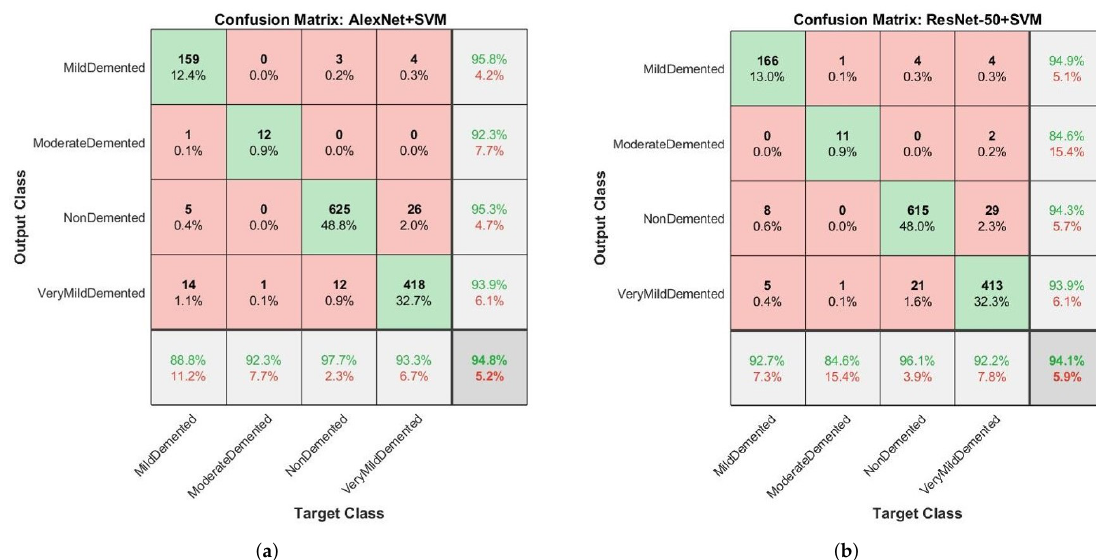
Figure 7. Confusion matrices. ( a ) Confusion matrix for the AlexNet-50+SVM to evaluate Alzheimer’s disease. ( b ) Confusion matrix for the ResNet+SVM to evaluate Alzheimer’s